Question: Draft a figure caption describing what is shown.
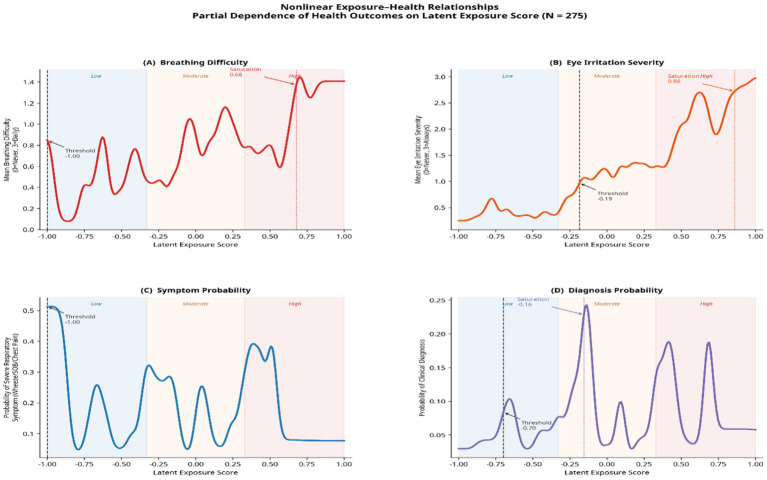
Answer: Nonlinear Exposure–Health Relationships. (A) Partial dependence of breathing difficulty on latent exposure score. (B) Partial dependence of eye irritation severity on latent exposure score. (C) Partial dependence of severe respiratory symptom probability on latent exposure score. (D) Partial dependence of clinical diagnosis probability on latent exposure score.